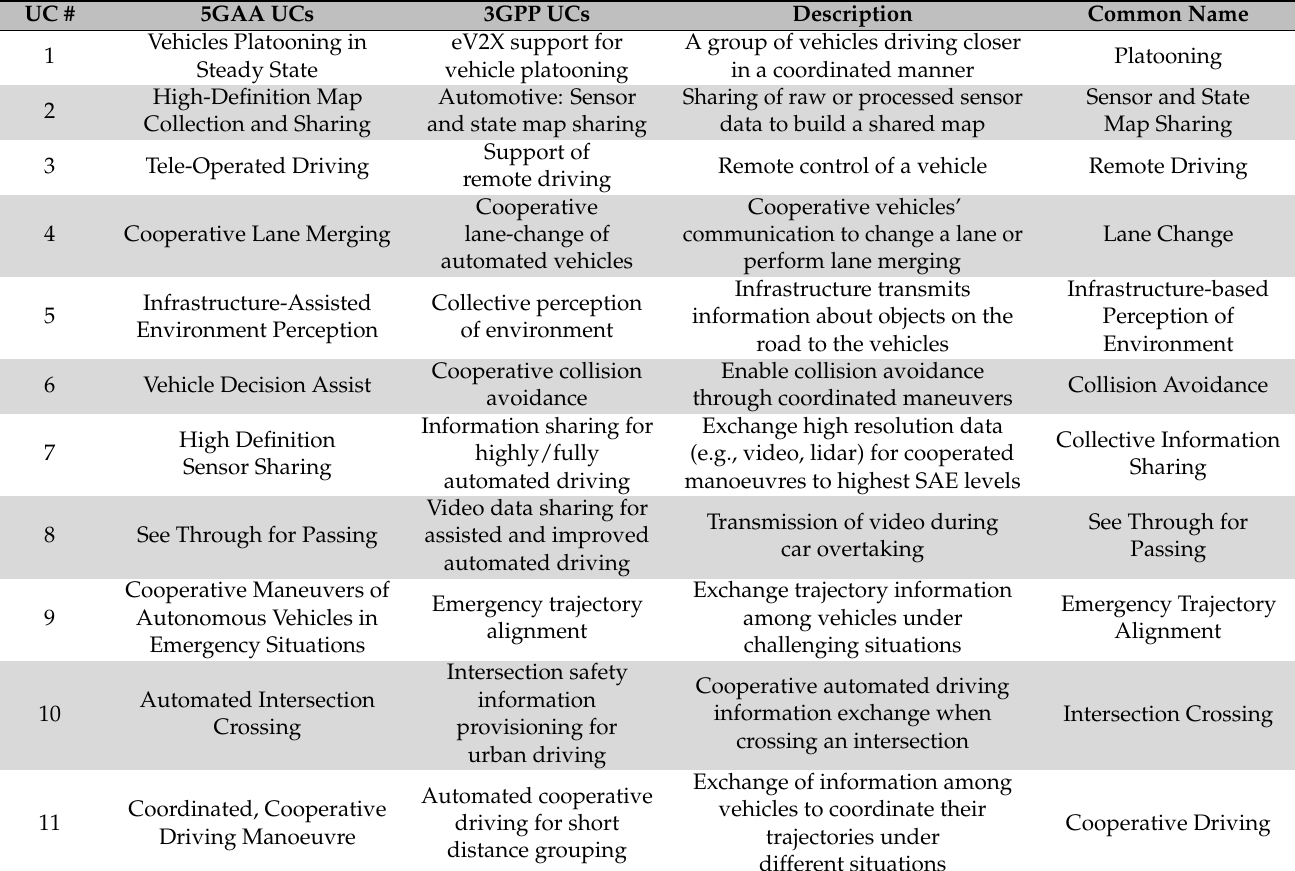
Table 1. Vehicle to Everything (V2X) use cases employed for delay and spectrum